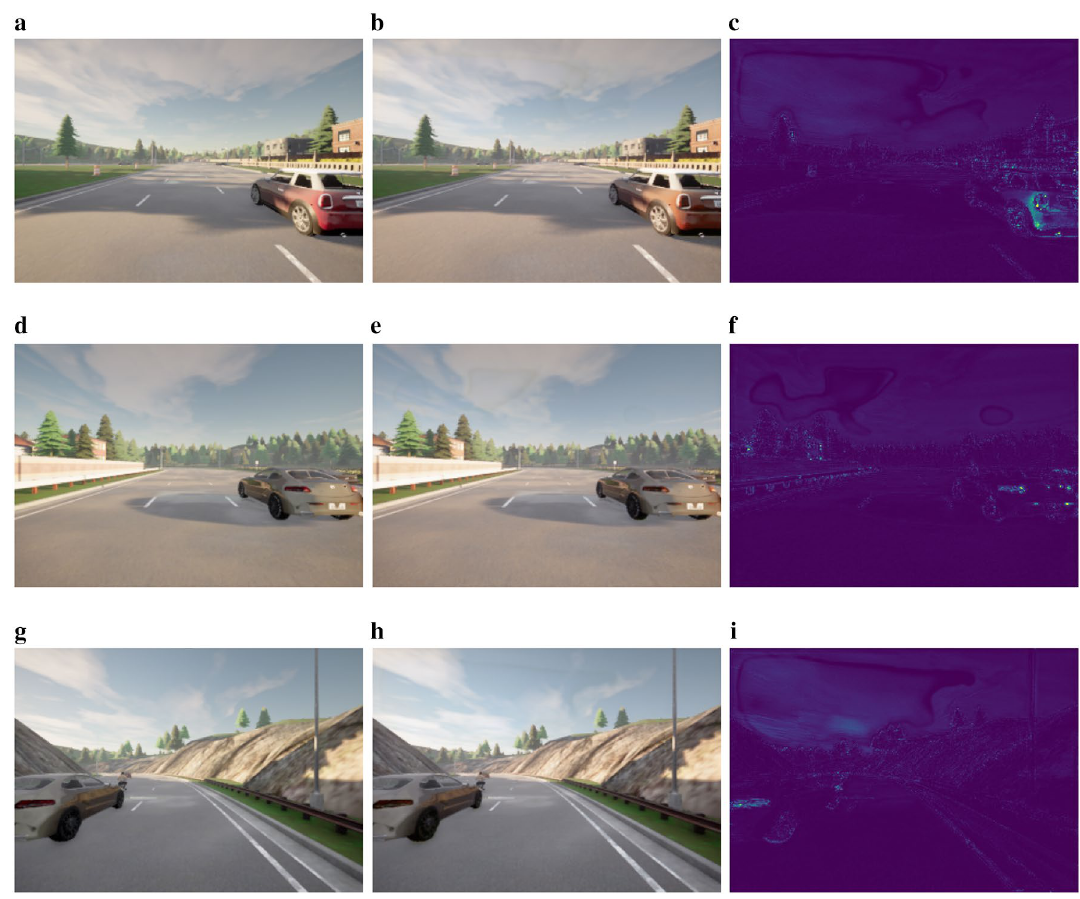
f reconstruction error image for the anomalous driving scenario (grey car), g input image for the anomalous driving scenario (grey car and cyclist), h reconstructed image for the anomalous driving scenario (grey car and cyclist), i reconstruction error image for the anomalous driving scenario (grey car and